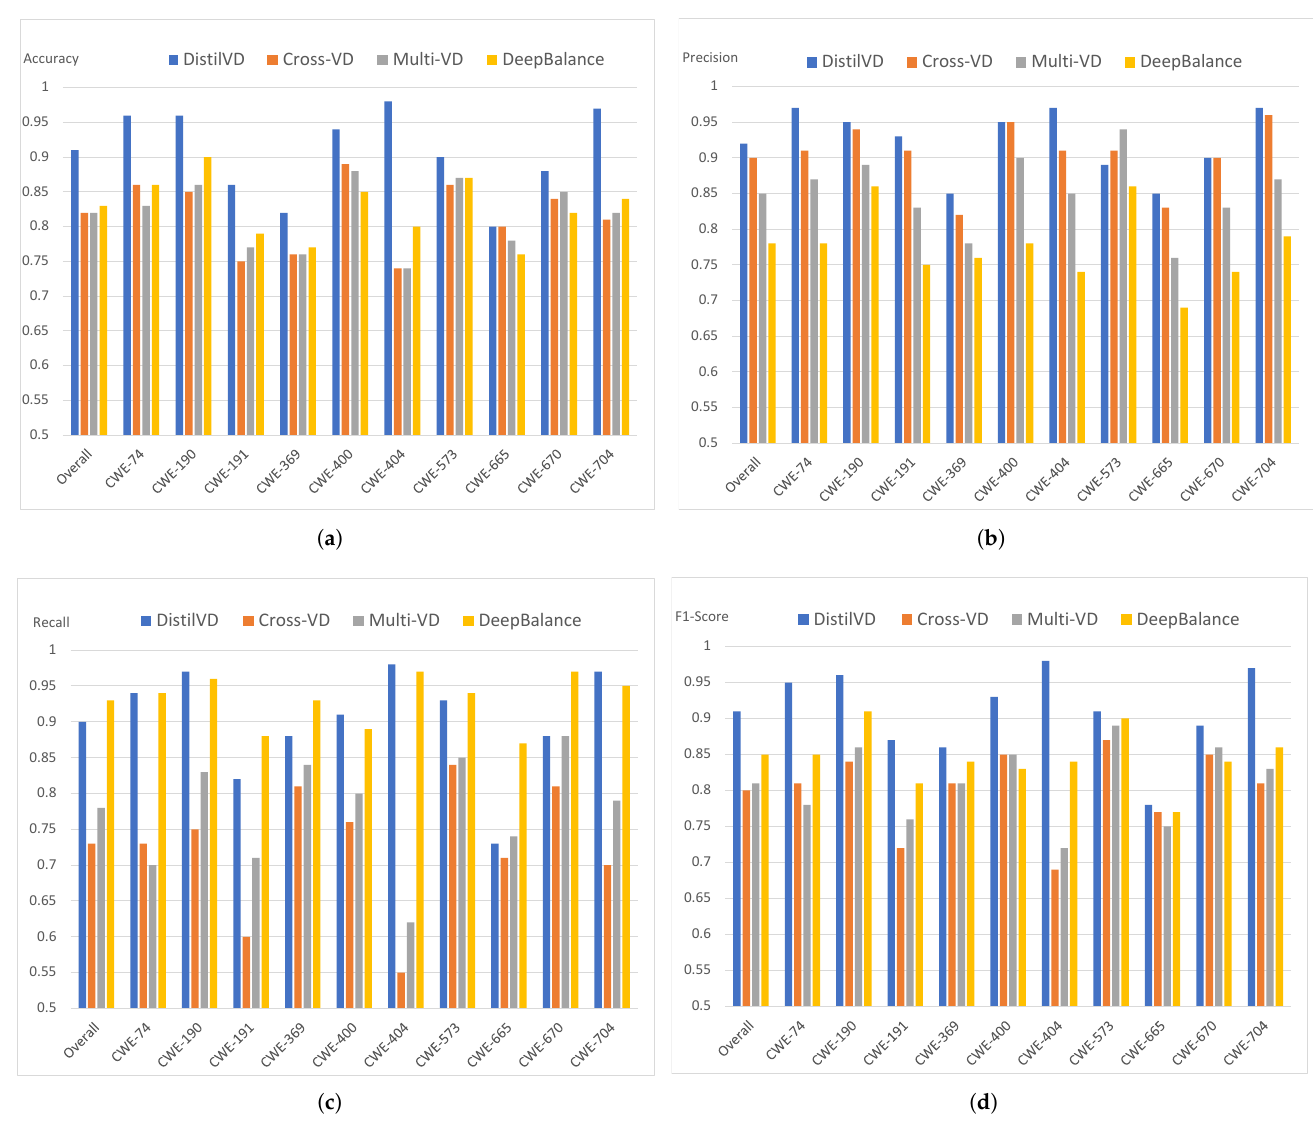
Figure 5. Performance comparison of the proposed framework (shown as DistilVD ), Cross-VD, Multi-VD, and DeepBalance for detecting overall vulnerabilities and individual vulnerability types. ( a ) the accuracy achieved by four systems; ( b ) the precision achieved by four systems; ( c ) the recall achieved by four systems; ( d ) the F1-score achieved by four